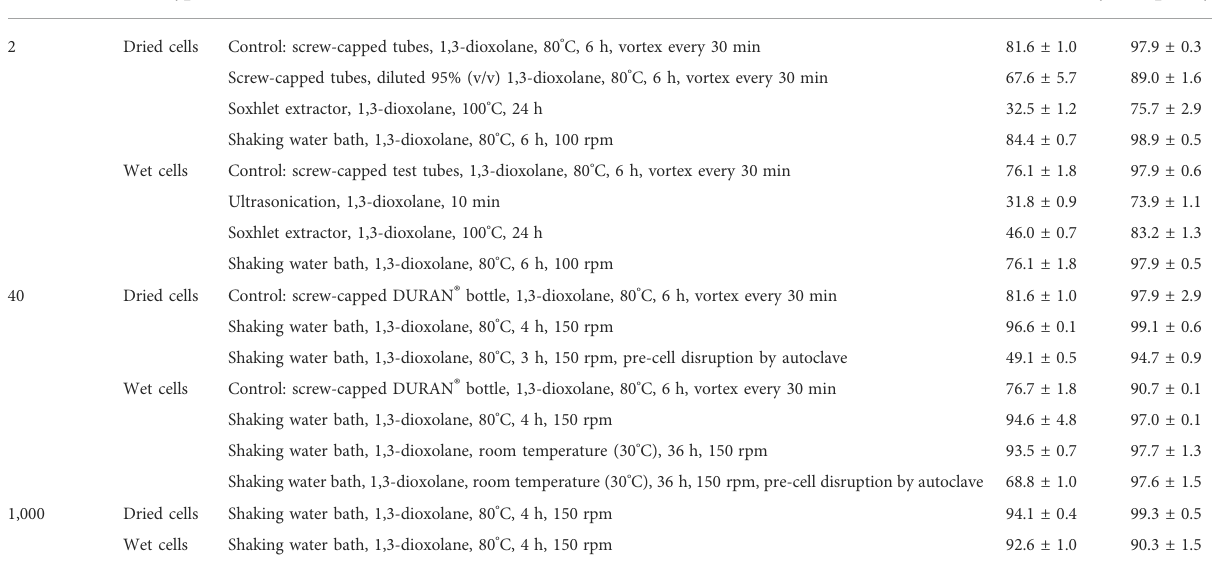
TABLE 1 Summary of results obtained from various types of PHB extraction methods from dried and wet cells using 1,3-dioxolane. Scale (ml) Cell type Extraction